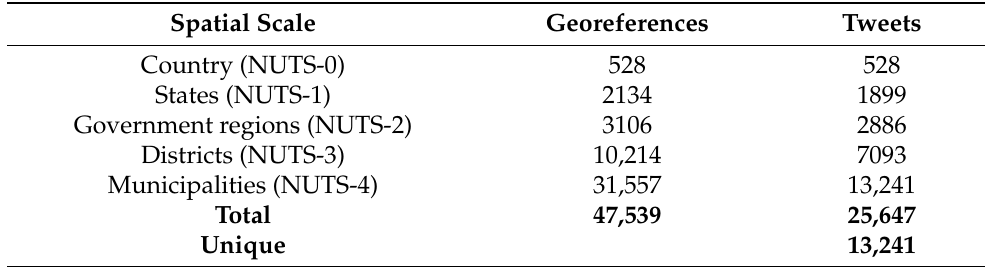
Table 1. Detected georeferences according to five administrative scales. The unique text bodies of the 13,241 tweets refer to multiple